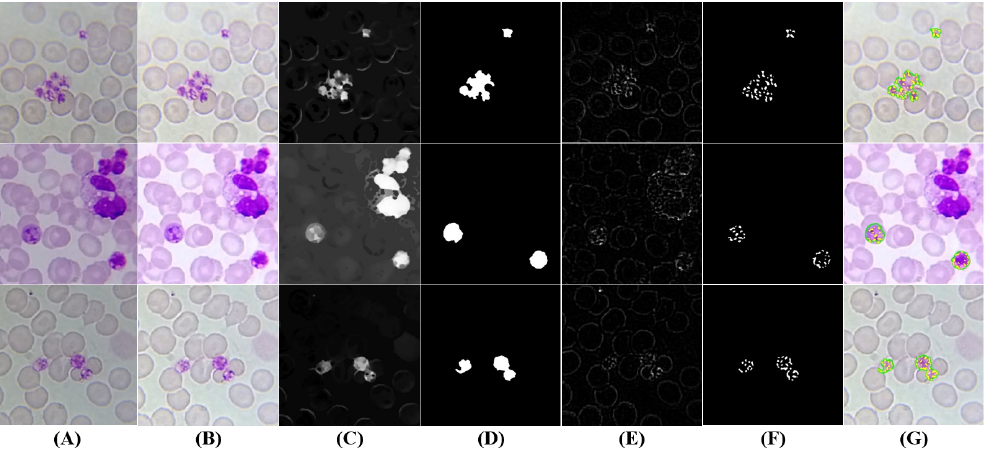
Figure 9. Examples of schizonts candidates: ( A ) original image (cropped ROI); ( B ) brightness and contrast enhancement; ( C ) cytoplasm grayscale sharpening; ( D ) cytoplasm segmentation and filtering; ( E ) merozoites’ chromatin grayscale sharpening; ( F ) Merozoites’ chromatin segmentation and filtering; ( G ) final schizonts candidates (cytoplasm in green; chromatin in